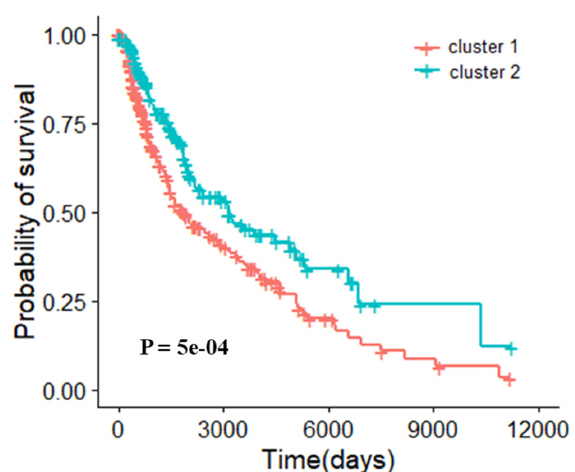
Figure 5. Survival analysis of di ff erent types of skin cutaneous melanoma samples after clustering (K = 2).